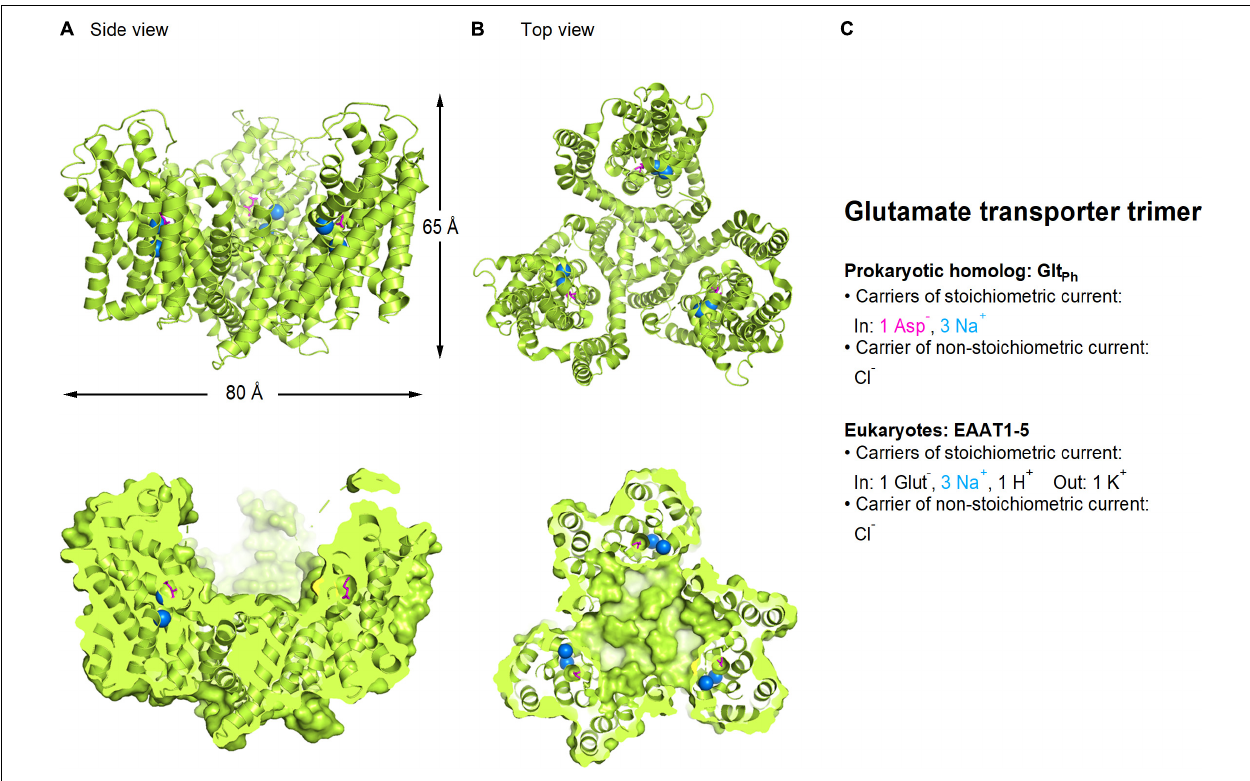
FIGURE 1 | Crystal structure of Glt Ph , a bacterial homolog of glutamate transporters (PDB: 2NWX). (A) Side view of the glutamate transporter trimer parallel to the membrane, using a ribbon ( top ) and a surface representation sliced through the center of the transporter basin ( bottom ). (B) As in A, viewed from the extracellular side of the membrane. Aspartate ( magenta ) and sodium ions ( blue ) are represented as spheres. (C) Summary of the main feature of the stoichiometric and non-stoichiometric current mediated by glutamate transporters in prokaryotes and eukaryotes, respectively. Image generated using The PyMOL Molecular Graphics System (Version 2.3.2; Schrödinger,